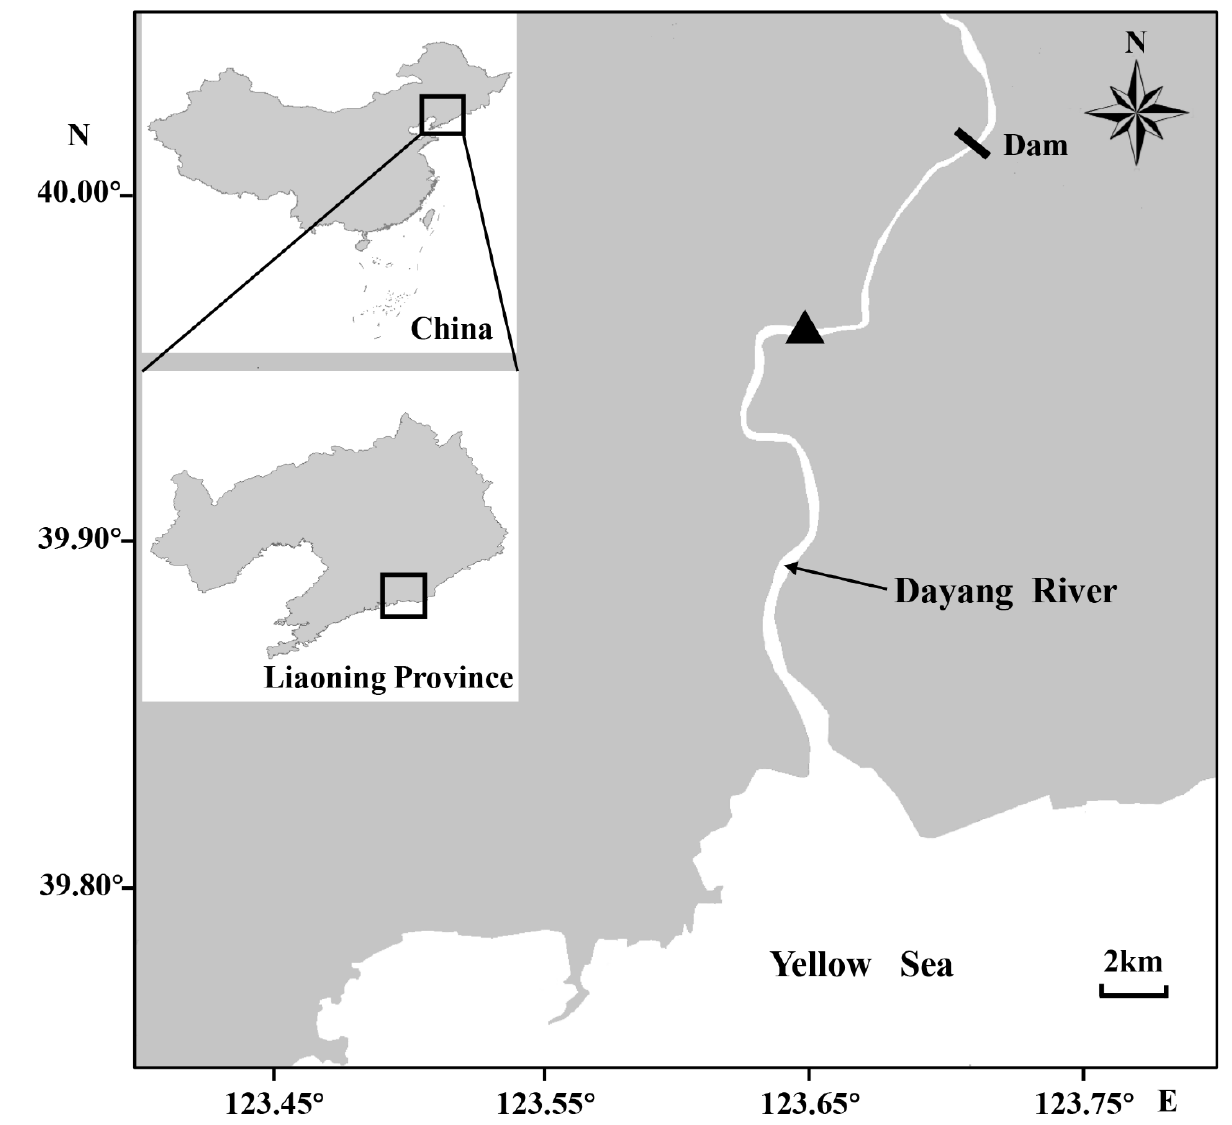
Figure 1. Sampling site ( ▲ ) of Coilia nasus in the Dayang River in southeast Liaoning Province, China. Table 1. Sampling details of Coilia nasus .